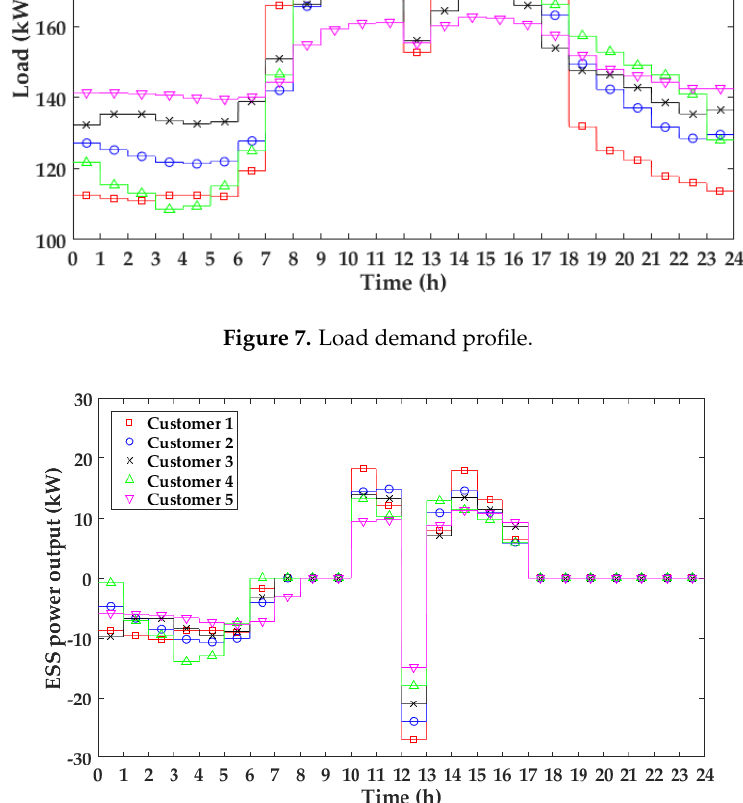
Figure 8. ESS charging schedule based on the TOU tariff.